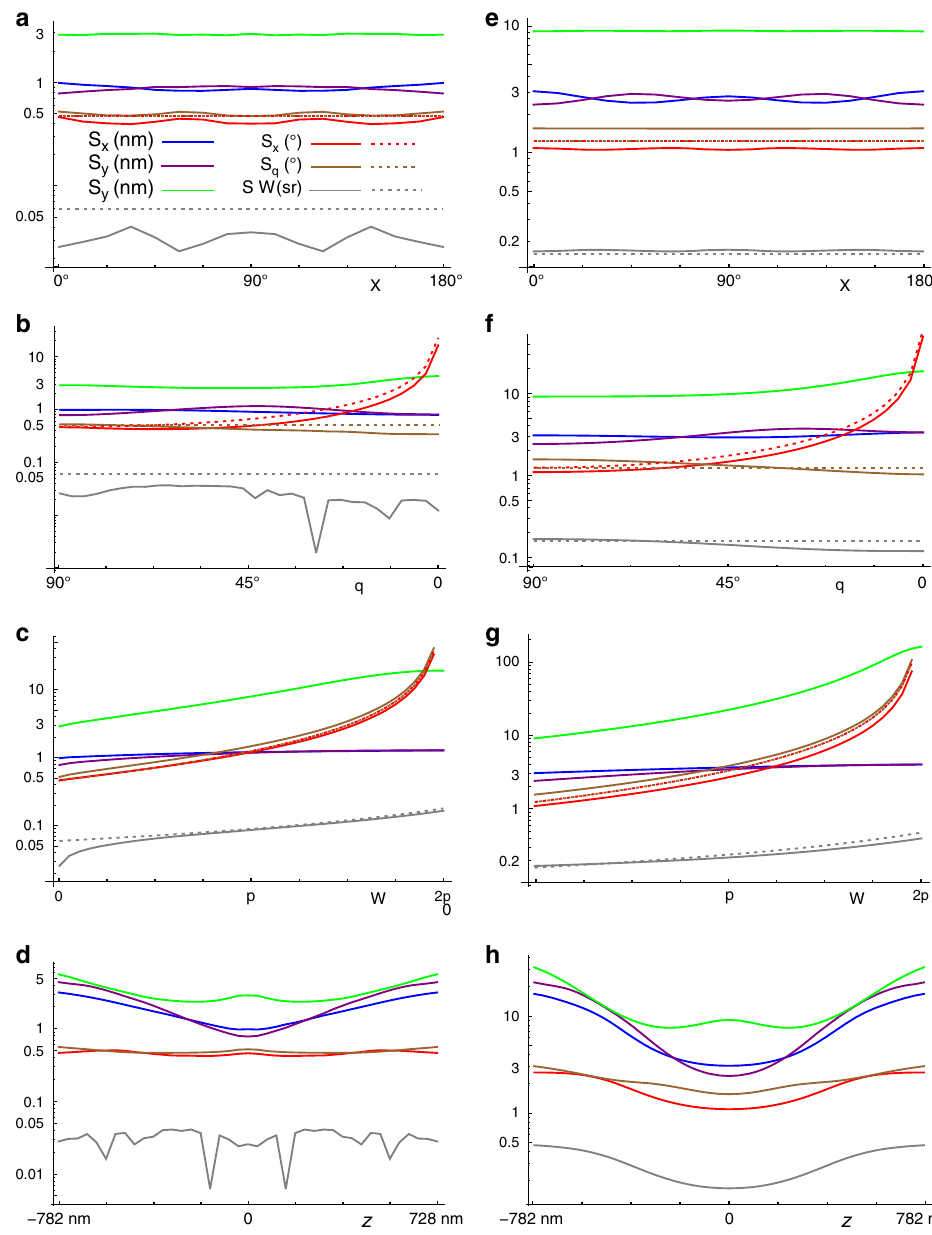
Fig. 4 Cramer – Rao lower bounds for the six measured parameters. These plots assume 10,000 signal photons over both channels, for a – d no background photons, and e – h a SBR of 1/3, corresponding to a background of about 250 photons per pixel. The parameters are a , e x = y = z = 0, θ = 90°, Ω = 0, and varying ξ ; b , f x = y = z = 0, ξ = 0°, Ω = 0, and varying θ ; c , g x = y = z = 0, ξ = 0°, θ = 90°, and varying Ω ; d , g x = y = 0, ξ = 0°, θ = 90°, Ω = 0, and varying z . The units for each curve are indicated in the legend in ( a ). The dashed lines indicate the simple estimates in Eq.